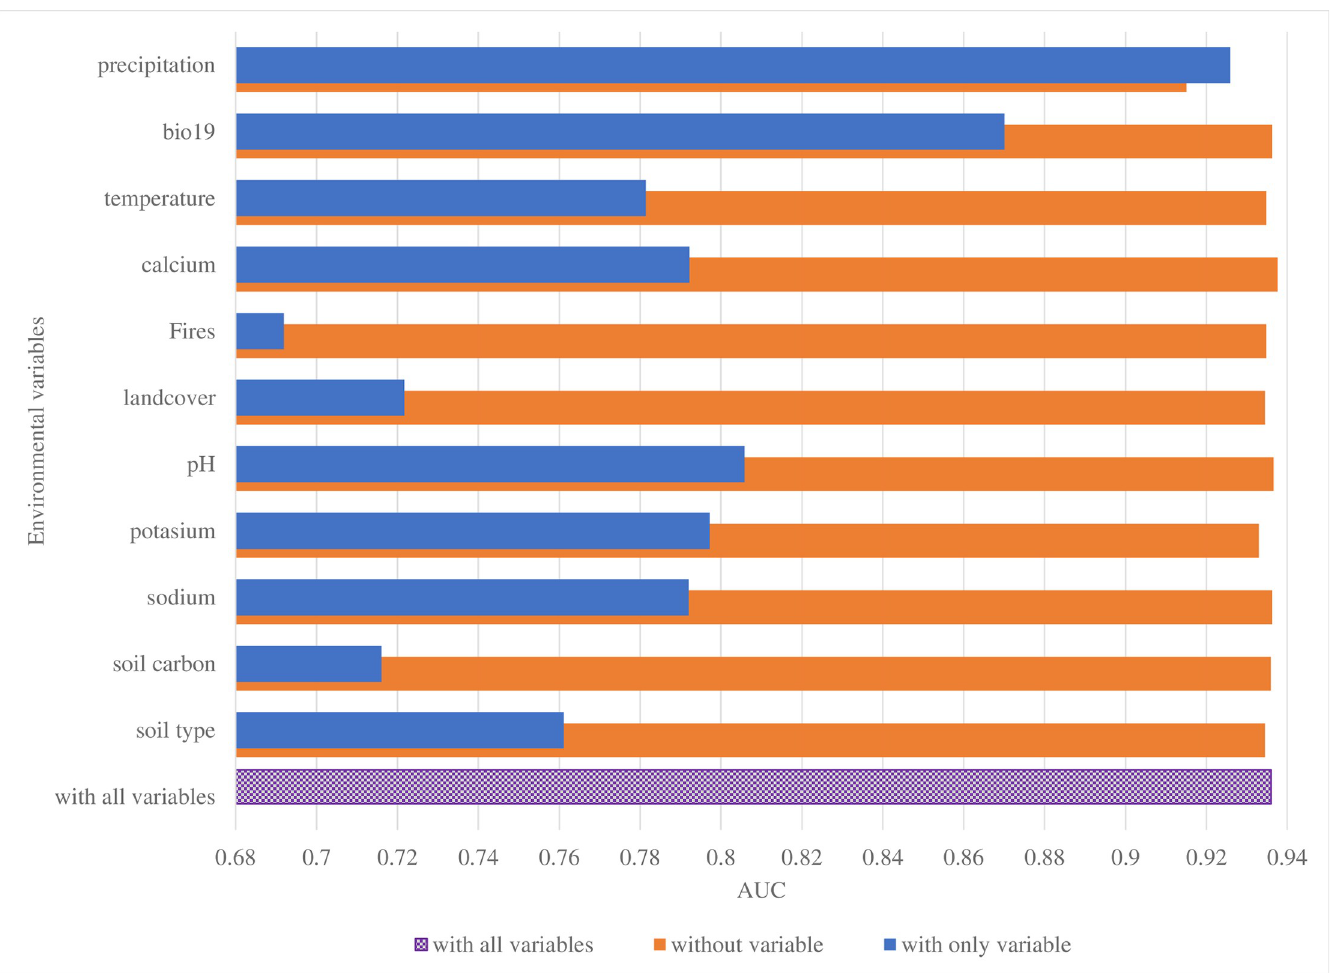
Fig 4. Jacknife test for assessing variable importance using Area under the receiver operating curve (AUC) on test data. Variable bio12_cl by itself registered the highest test AUC (0.925) for measuring model accuracy. All variables with AUC � 0.75 had significant contribution to the model. AUC thresholds of 0.6–0.7 are classified as poor, 0.7–0.8 as average, 0.8–0.9 good, 0.9–1.0 as excellent [23,